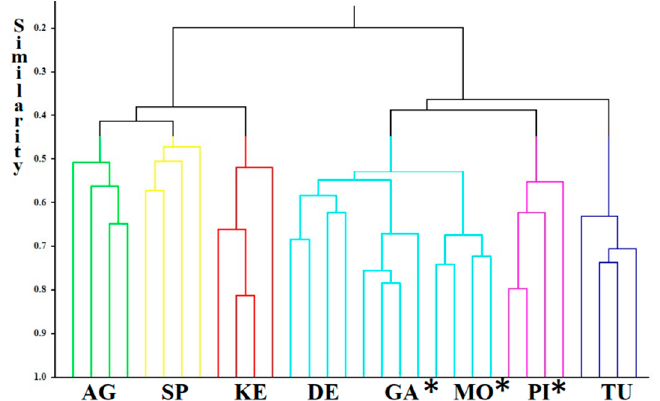
Figure 3. Dendrogram showing the hierarchical clustering of potato samples based on the morpho- agronomic descriptors. Asterisks indicate the accessions from Majella National